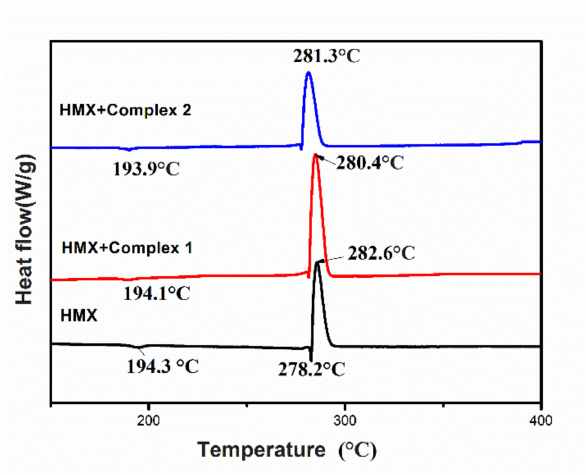
Figure 6. DSC curves of the HMX, HMX with complex 1 and HMX with complex 2 .